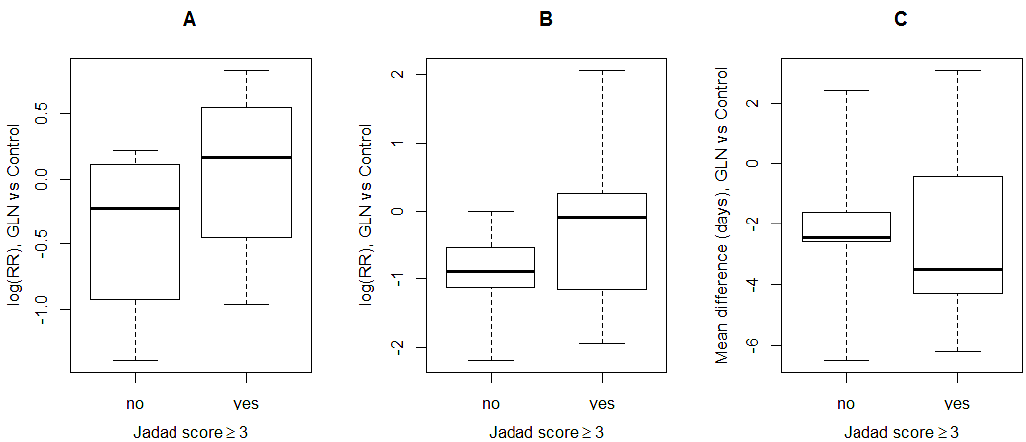
Figure 7. Box-plots comparing the distribution of the GLN effect between high quality (Jadad score ≥ 3) and low quality studies (Jadad score < 3) for overall morbidity ( A ), infectious morbidity ( B ) and length of stay ( C ). GLN: glutamine, RR: relative risk, log: natural